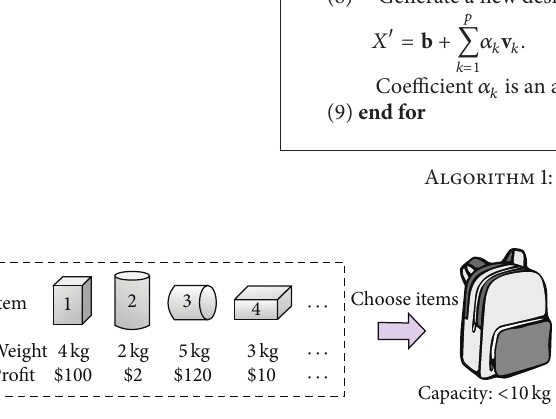
Figure 3: Knapsack problem.